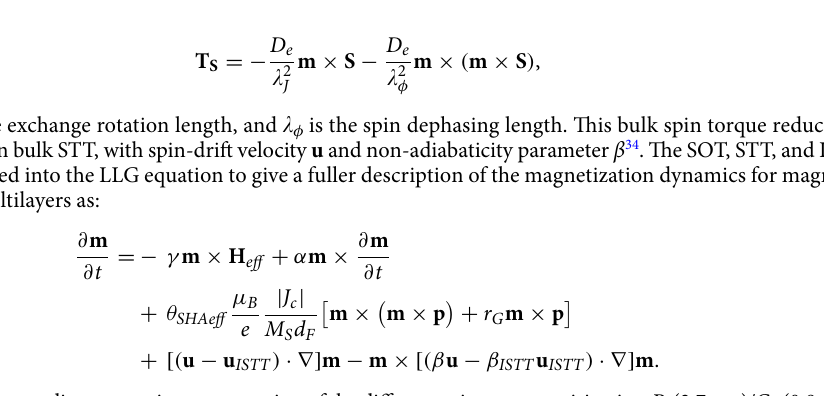
Figure 1. Diagrammatic representation of the origins of different spin torques in a Pt/Co/Ir multilayer. The SHE gives rises to vertical spin currents (indicated by solid arrows) flowing from Pt (and to a much smaller extent Ir) into Co, resulting in SOT. Spin accumulation at the skyrmion in Co gives rise to diffusive vertical spin currents (dashed arrows), flowing from Co into Pt and Ir, resulting in ISTT. SOT and ISTT are obtained from the self-consistent interfacial spin torque—Eq. (1). Spin accumulation at the skyrmion in Co also gives rise to in-plane spin currents (small dashed arrow), resulting in the much weaker bulk STT—computed self- consistently using Eq.